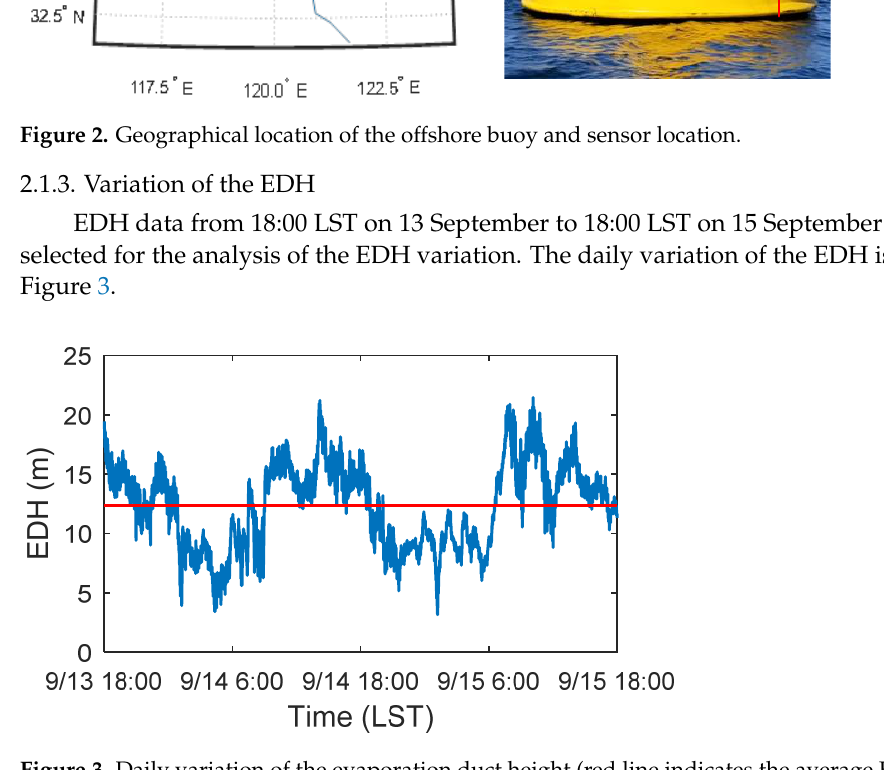
Figure 3. Daily variation of the evaporation duct height (red line indicates the average EDH). Figure 3 shows that the height of the evaporation duct regularly changes during the selected time period. At night (from 13 September 18:00 to 14 September 6:00, from 14 September 18:00 to 15 September 6:00), the EDH is low, with a minimum of ~5 m; in the daytime (from 14 September 6:00 to 14 September 18:00, from 15 September 6:00 to 15 September 18:00), the EDH is higher, reaching up to 20 m. However, this change is not always constant and sometimes opposite to the change shown in the graph. It is certain